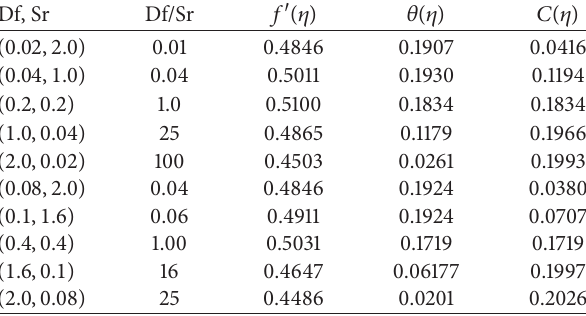
Table 4: Comparison of the values of velocity, temperature, and concentration for different values of Df and Sr with 𝜂 = 0.5 and 𝑁 = 0.5 for opposing external flow (Gr/Re = −